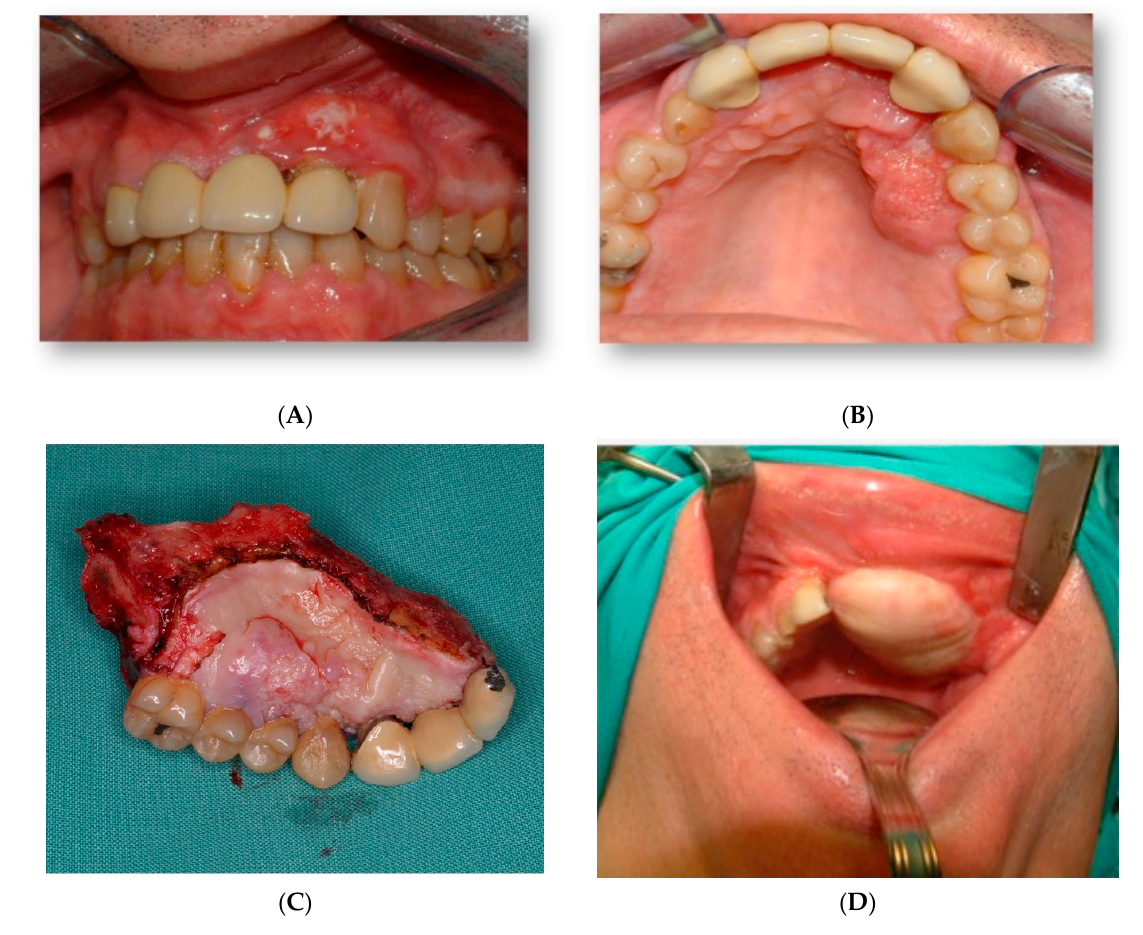
Figure 1. Intraoral view. ( A , B ) Maxillary squamous cell carcinoma with mobility of teeth. ( C ) Resection piece after excision of the tumour. ( D ) Microvascularized fibula flap.